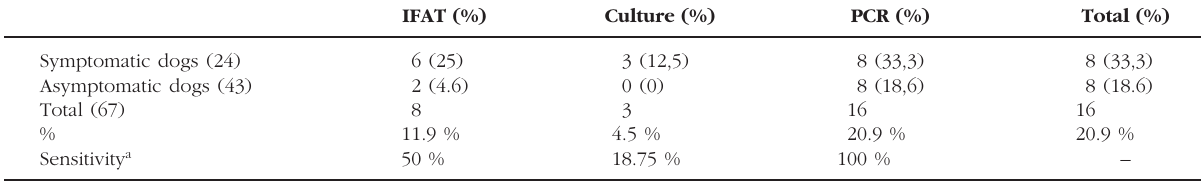
Table II. – Sensitivity of different methods used in the detection of Leishmania